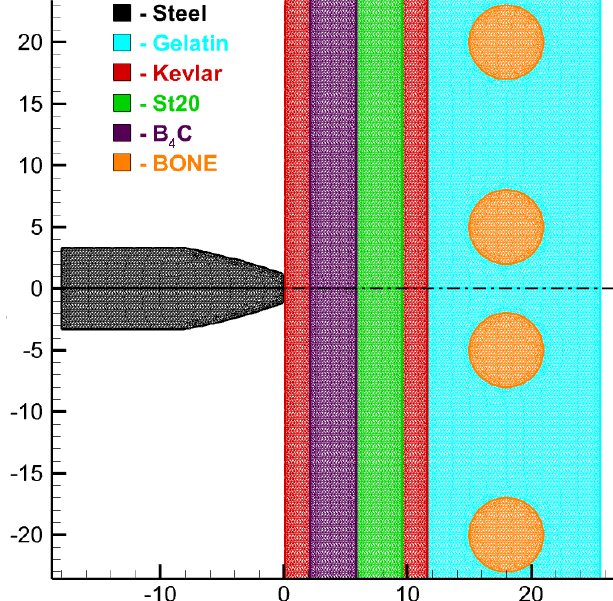
Fig. 1. The protective element is a two-layer plate (ceramic+steel) in a Kevlar pocket, model